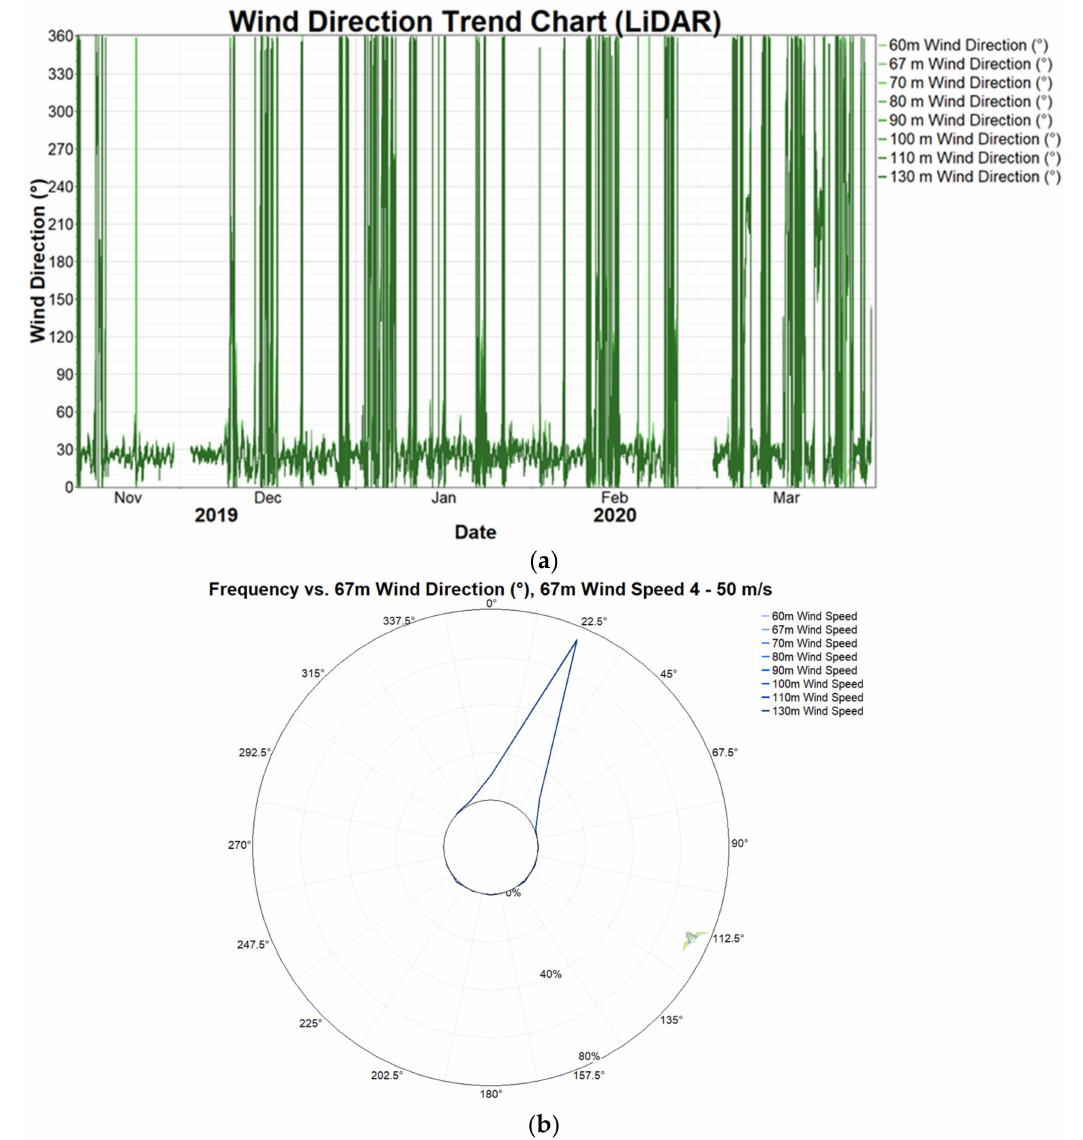
Figure 5. ( a ) Wind direction measured by LiDAR; ( b ) wind rose map for multiple levels. The diurnal profile in Figure 6 shows about 30% variation in wind speed within a full day, with wind speed obviously increasing between 10:00 and 17:00 and decreasing afterwards. The diurnal-temperature profile in Figure 6 is similar to the wind-speed profile because vigorous air flow with higher temperatures above the ground or sea level can induce higher wind speed. The daily strongest wind occurred at about 17:00 and had the same trend as that of